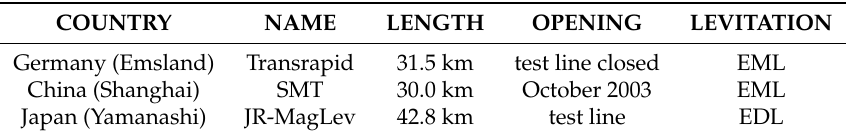
Table 1. High speed MagLev